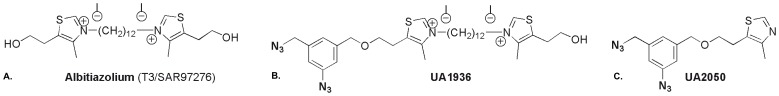
Structure of albitiazolium and photoactivable analogs.(A) The clinical antimalarial candidate albitiazolium, (B) the bifunctional bis-thiazolium derivative UA1936 and (C) the pharmacologically inactive bifunctional derivative UA2050 are depicted. The albitiazolium pharmacophore consists of two cationic thiazolium heads linked by a hydrophobic flexible spacer. The bifunctional compounds UA1936 and UA2050 incorporate a phenyl azido group as photoactivable moiety and a benzy azido group as “clickable” function.